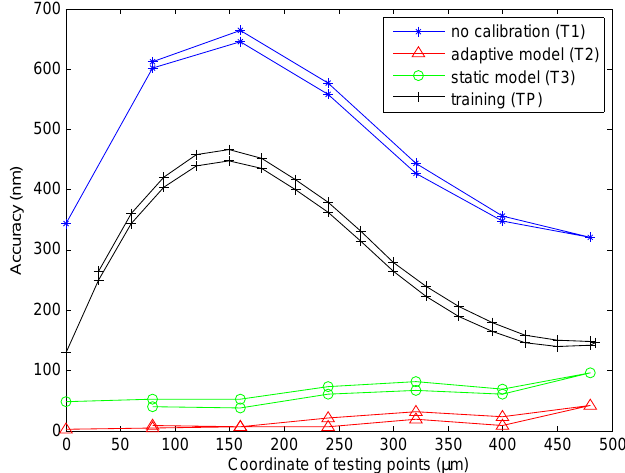
Figure 11. Accuracy of the training phase (TP) and first three tests (T1, T2, and T3).